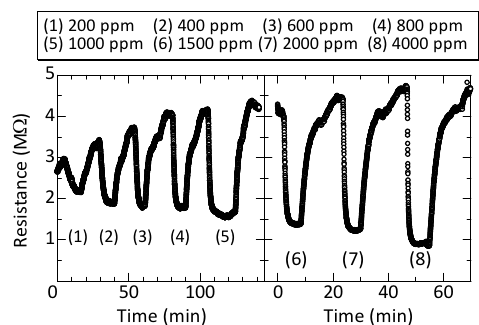
Figure 7. Time-dependent resistance change of the La 2 O 3 /SnO 2 element for different CO 2 concentrations. The measurement was interrupted between (5) and (6) for several tens of a second because of the limitation of the measuring instrument.